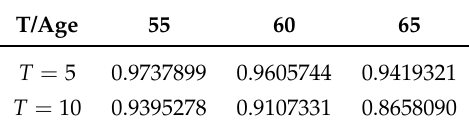
ˆ p for different ages and T x